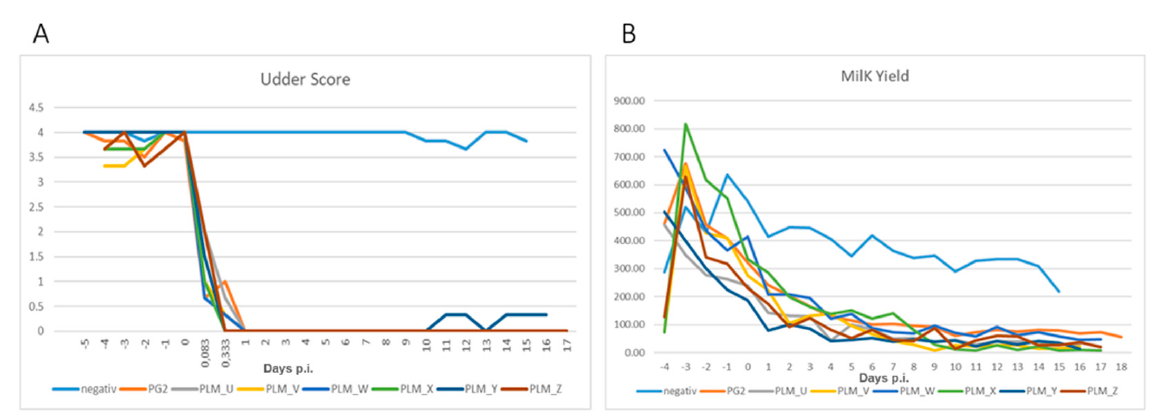
Figure 3. M. agalactiae load in milk samples obtained from the inoculated right udder halves of ewes experimentally infected with 10 9 cfu of six different Vpma PLMs (PLMV, PLMX, PLMZ, PLMW, PLMY and PLMU) and type strain PG2. Mean log 10 cfu values of mycoplasmas per milliliter of milk from three sheep in each group are plotted and bars represent standard error of the mean. Milk samples from left udders were found positive for mycoplasmas only in a few sheep. This also started only at around one week after initial infection and persisted until the end of the infection trial (Figure S4). Two sheep each from the PLMV and PLMX in- fection groups, and one from PG2 group, showed a similar trend, with the highest counts witnessed between Day 11 and Day 13 p.i. For PLMZ, one sheep exhibited a single spo- radic positive result on Day 1 p.i. and was found to be negative on all subsequent days. The earlier M. agalactiae intramammary infection trials had yielded sporadic re-isolations from the milk of left uninoculated udder halves [13] with much lower loads compared to the current study, except for the PG2-infected sheep. As observed during earlier myco- plasma mastitis cases, the excretion of mycoplasmas in milk showed a biphasic trend with alternate high and low phases of recovery, likely due to immune modulation [13,24].